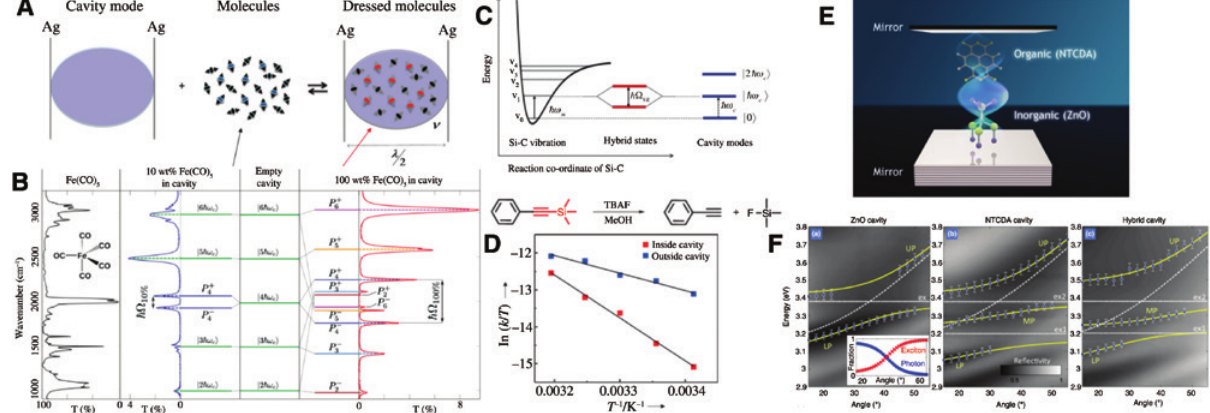
Figure 4: Experiments demonstrating collective strong light-matter coupling. (A) Adapted with permission from Ref. [123] (© 2015 Springer Nature). (B and C) Adapted with permission from Ref. [20] (© 2016 The American Association for the Advancement of Science). (A) General setup [5] when organic molecules are placed between two Ag mirrors that form an optical cavity to create dressed polaritonic states. (B) Transmission spectrum of such a system. By increasing the density of the Fe(CO) compound in the optical cavity, the system shows a transition from the strong (blue) to the ultra-strong (red) coupling 5 limit [32]. (C) Top: Schematic illustration of a strong coupling experiment [8]. The first excitation of an Si-C vibrational mode is strongly coupled to a cavity mode of the same frequency, leading to a Rabi splitting. Bottom: Deprotection reaction of PTA with TBAF. (D) Reaction rate depending on the temperature for reactions inside the cavity (red) and outside the cavity (blue) [8]. (E) Experimental setup [11] of the organic and inorganic molecules that are strongly coupled in a microcavity. (F) Strong light-matter coupling leads to a Frenkel- Wannier-Mott hybridization of excitons [11]. UP, MP, and LP denote the upper, middle, and lower polaritons, respectively. (A) Adapted with permission from Ref. [5] (© 2016 American Chemical Society). (B) Adapted with permission from Ref. [32] (© 2016 American Physical Society). (C and D) Adapted with permission from Ref. [8] (© 2016 John Wiley and Sons). (E and F) Adapted with permission from Ref. [11] (© 2014 American Physical